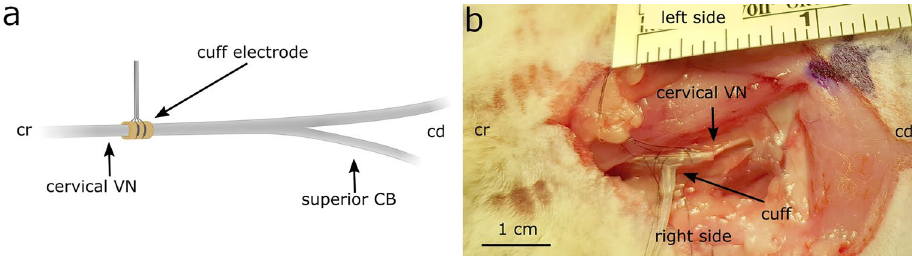
Figure 2. ( a ) Schematic of a cuff electrode wrapped around the cervical VN at mid-cervical level, approximately 4–5 cm cranial to the cardiac branching point of the superior cardiac branch. ( b ) Surgical window of a rabbit instrumented with the cuff electrode placed at the mid-cervical level. Cr cranial, cd caudal, CB cardiac branch, VN vagus nerve.